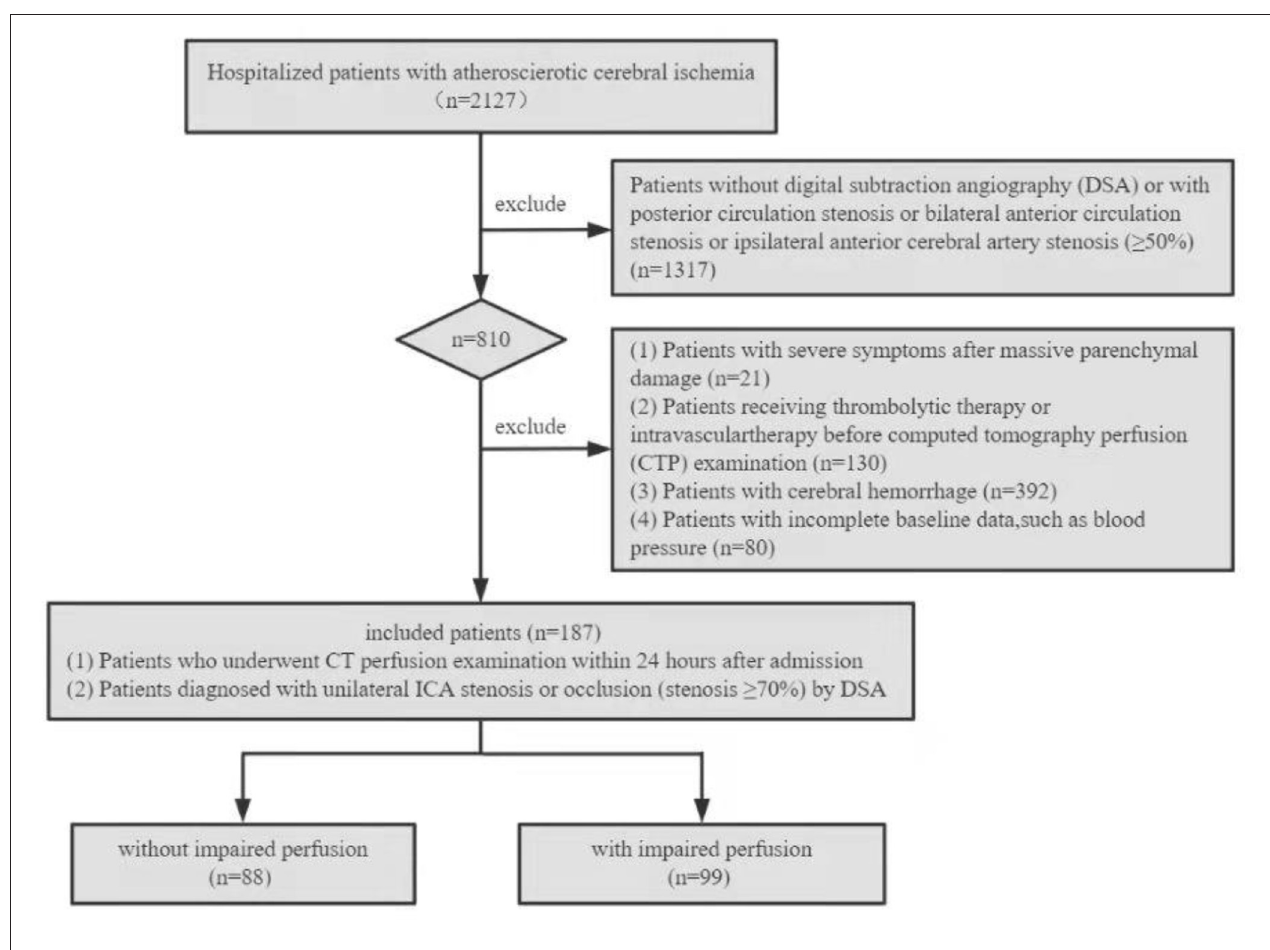
FIGURE 1 | Flowchart of study population